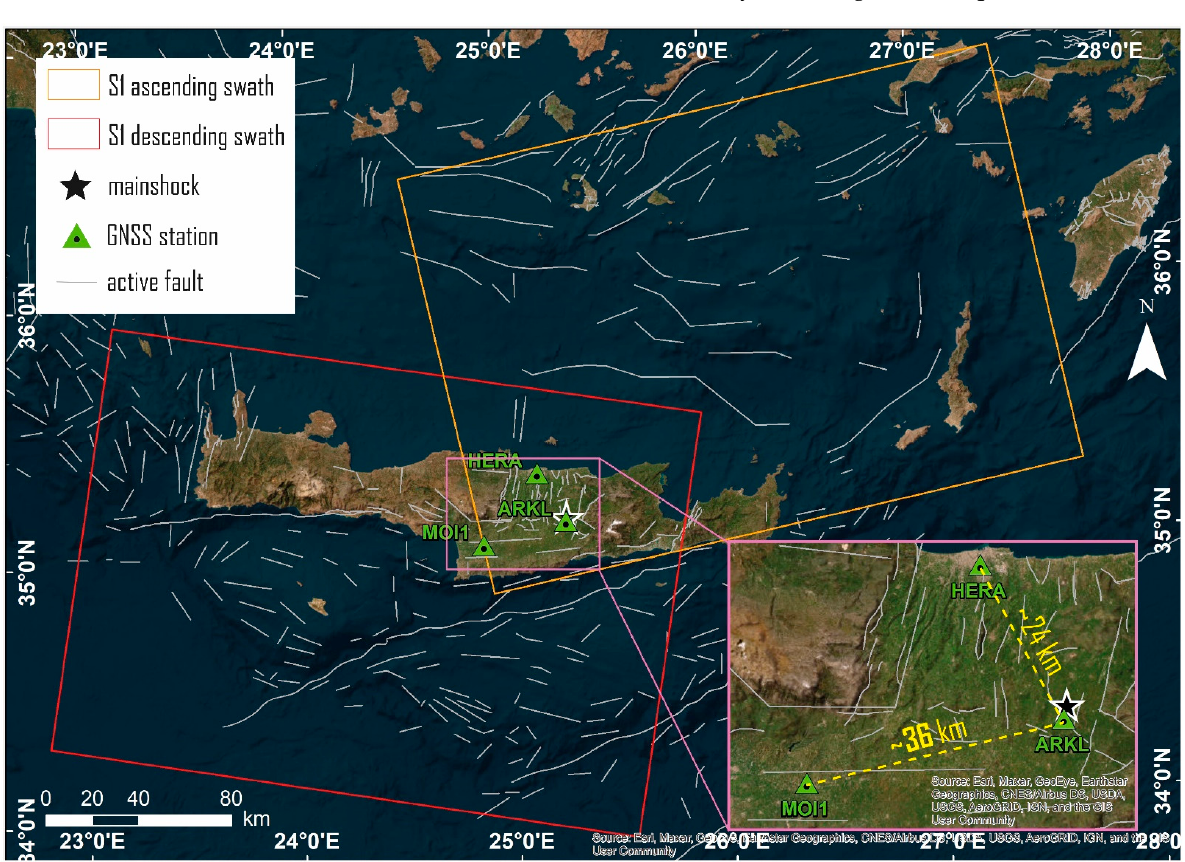
Figure 2. The location of the three permanent GNSS Crete Stations and IW Swath of Sentinel 1 images. Basemap reprinted/adapted with permission from Sources: Esri, DigitalGlobe, GeoEye, i- cubed, USDA FSA, USGS, AEX, Getmapping, Aerogrid, IGN, IGP, swisstopo, and the GIS